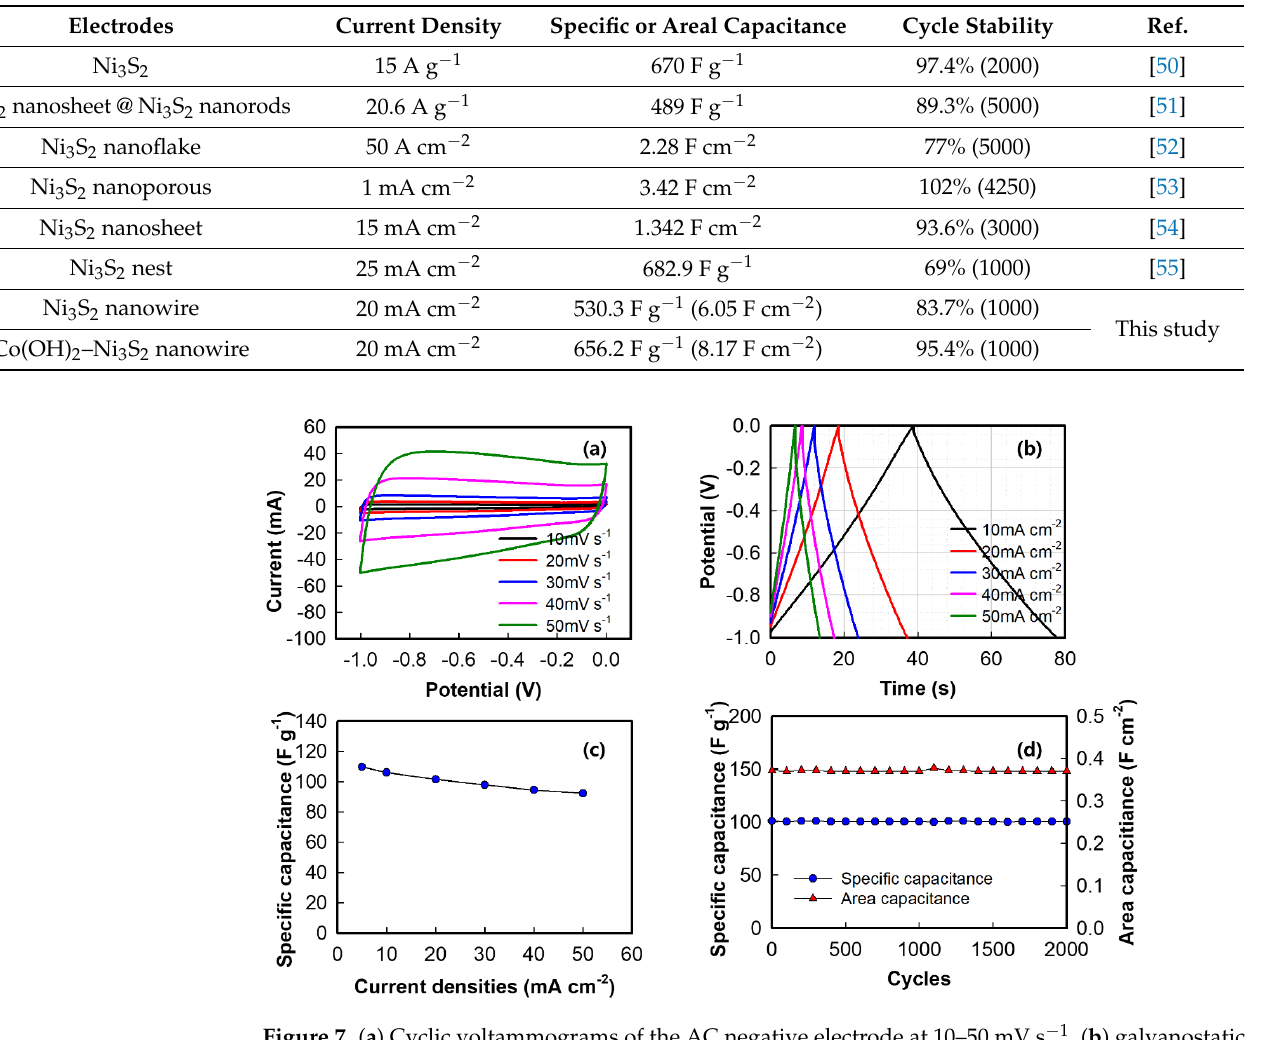
Figure 7. ( a ) Cyclic voltammograms of the AC negative electrode at 10–50 mV s −1 , ( b ) galvanostatic charge–discharge curves of the AC electrode at 10–50 mA cm −2 , ( c ) specific capacitances at different current densities, and ( d ) cycling performance of the AC electrode at 20 mA cm −2 . The ASC device was assembled in a two-electrode configuration using a Co 0.5 –Ni 3 S 2 positive electrode and an AC negative electrode. Prior to assembling the ASC device, the mass balance of the positive and negative electrodes was determined. The mass (m) of the positive and negative electrodes was determined by Equation (3) [70]: